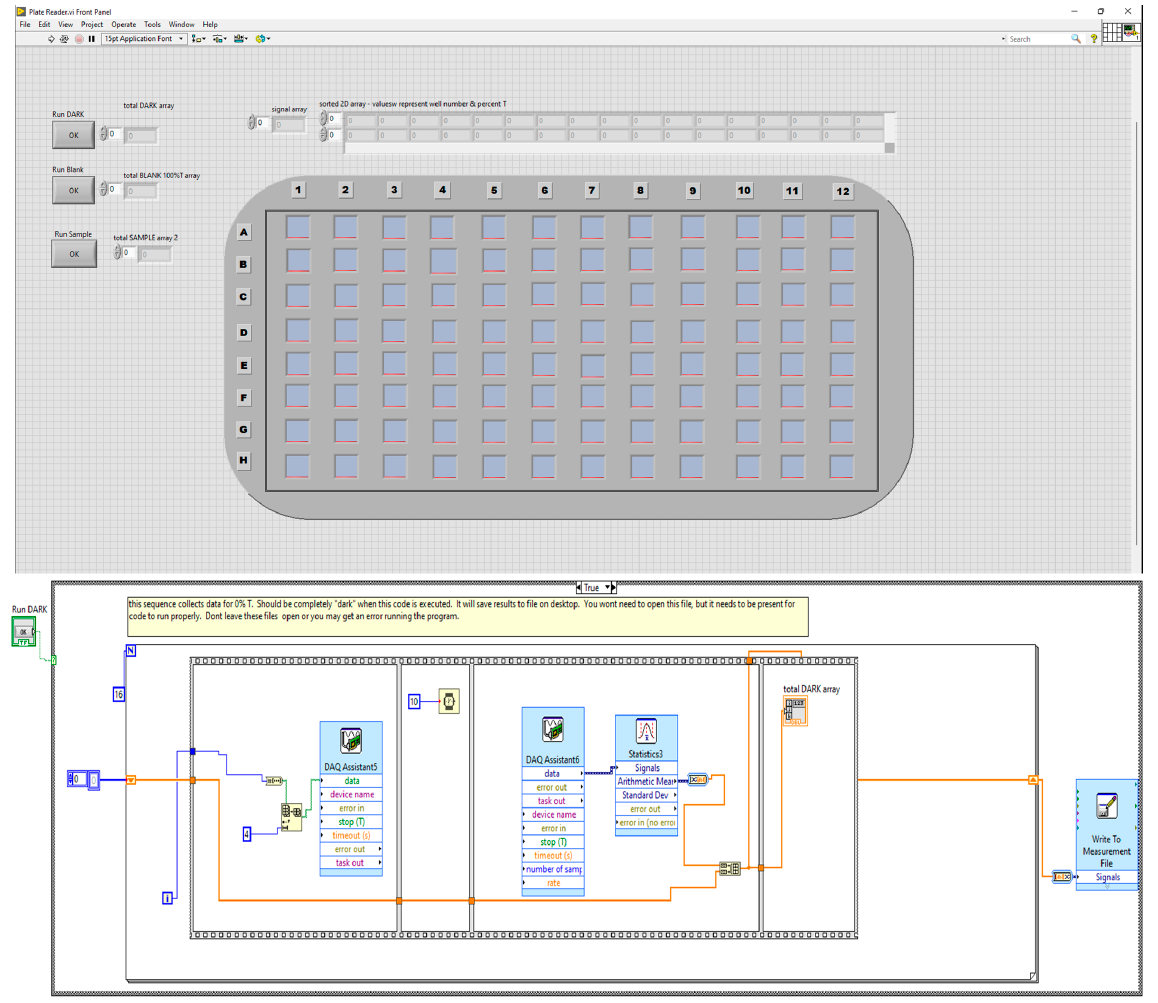
Figure 2. Portion of plate reader code written in LabView. ( Top ) Front panel user interface. ( Bottom ) Block diagram.